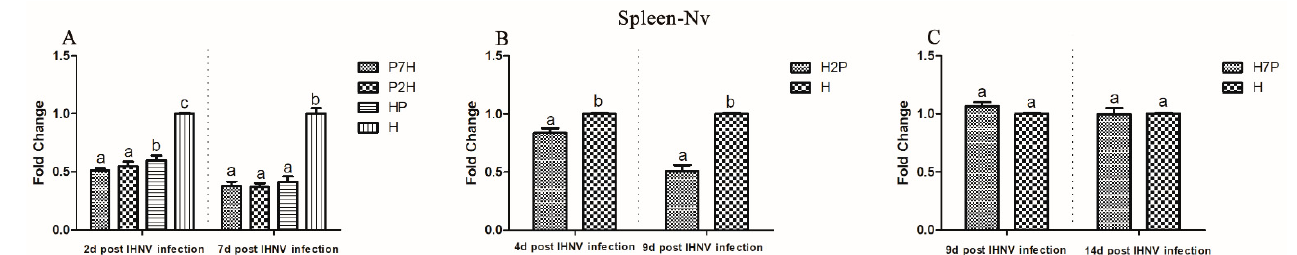
Figure 7. IHNV Nv genes in the spleen determined by qRT-PCR. Rainbow trout challenged with IHNV (group H) were used as controls. Different letters on the bar charts indicate statistically significant differences ( p < 0.05). ( A ) The levels of IHNV Nv gene in groups P7H, P2H, and HP. ( B ) The levels of IHNV Nv gene in group H2P. ( C ) The levels of IHNV Nv gene in group H7P.